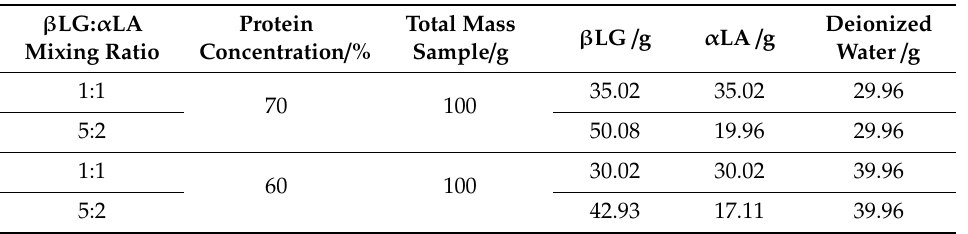
Table1. Concentrationofmainwheyproteinfractioninmodelsampleswithatotalproteinconcentration of 60% and 70% ( w / w